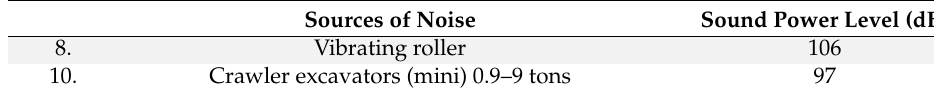
Table 23. Expected sources of construction noise.